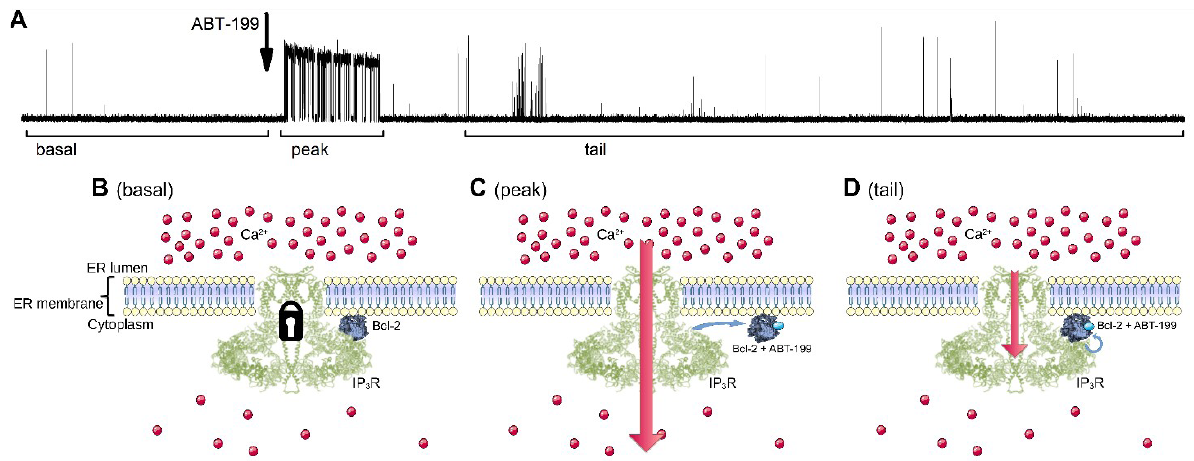
Figure 6. Schematic diagram illustrating the proposed model of how ABT-199 binding to the hydrophobic cleft of Bcl-2 influences IP R activity pattern in panel A. (B). The IP R is inhibited by Bcl-2 via its BH4 and TM domains, yielding a typical low-P 3 3 activity at basal stimulation levels. (C). The addition of ABT-199 leads to its binding in the hydrophobic cleft of Bcl-2, which leads to the “tail-flip” conformational change in the BH4 domain which, in turn, disrupts the ongoing inhibitory interaction of Bcl-2 and IP R exposing uninhibited IP R activity for a short period of time. (D). Bcl-2:ABT-199 complex rebinds the IP 3 3 affinity, yielding the partially inhibited gating pattern. TM: